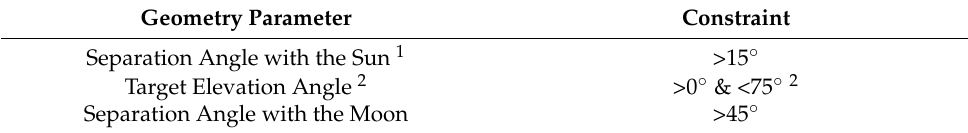
Table 3. Geometry constraints of the